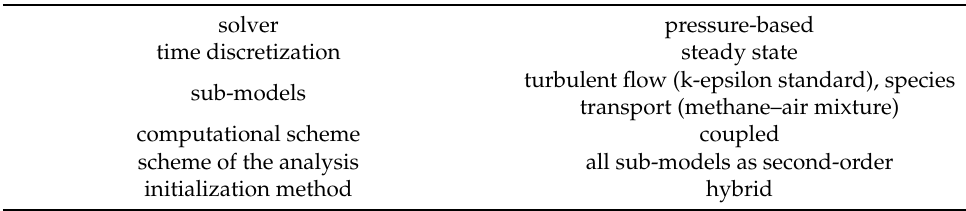
Table 2. Primary solver settings.